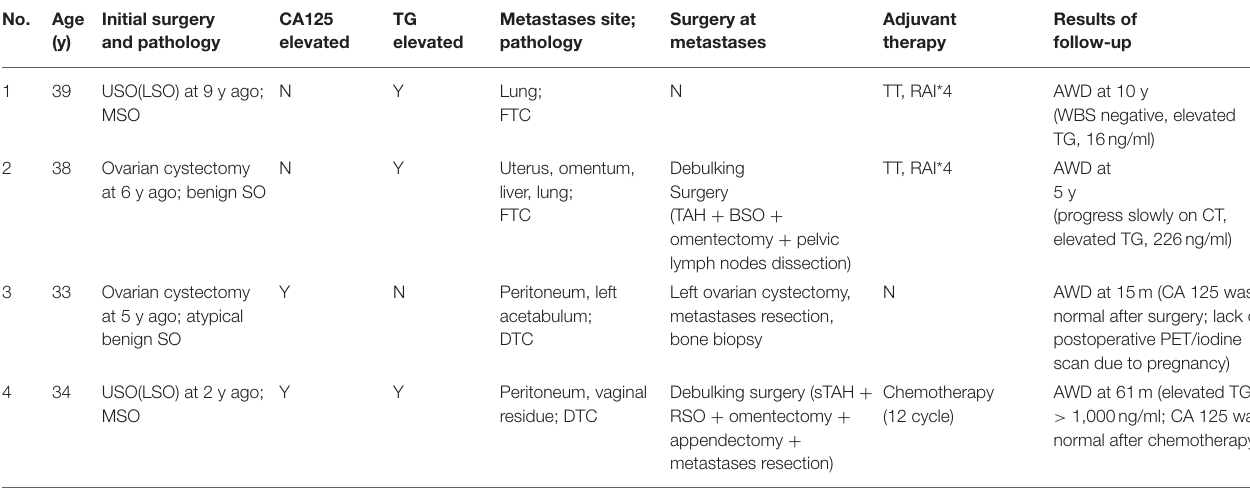
TABLE 1 | Demographic and clinical characteristics of the four patients. No. Age